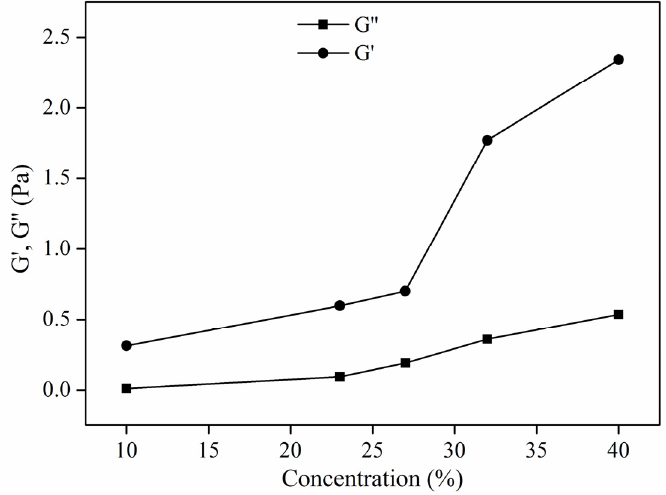
Figure 4. Viscoelasticity (G ′ , G ′′ ) of PS solutions with different